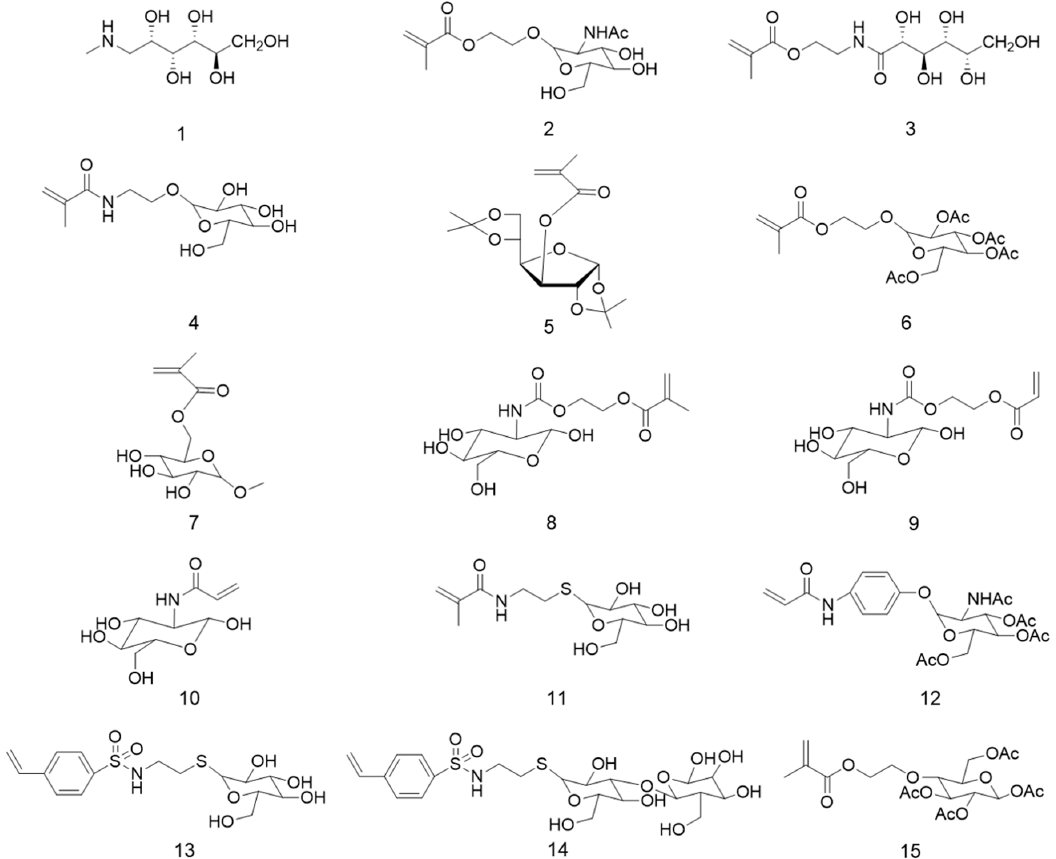
Figure 4. Chemical structure of N -methyl- ᴅ -glucamine ( 1 ) and protected and non-protected glucose-based vinyl monomers used for the synthesis of polymer brushes by RDRP. 2 : methacryloyloxyethyl ᴅ -glucopyranoside; 3 : ᴅ -gluconamidoethyl methacrylate; 4 : 2 ′ -acrylamidoethyl- β - ᴅ -glucopyranoside; 5 : 3- O -methacryloyl-1,2:5,6-di- O -isopropylidene- ᴅ -glucofuranose; 6 : 2-(2 ′ ,3 ′ ,4 ′ ,6 ′ ,-treta- O -acetyl- β - ᴅ -